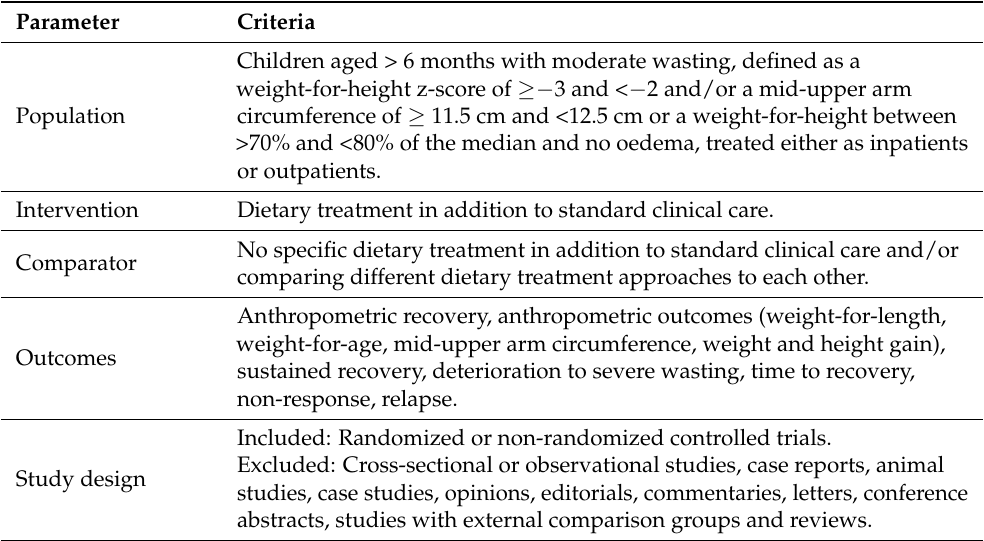
Table 1. PICOs criteria for inclusion of